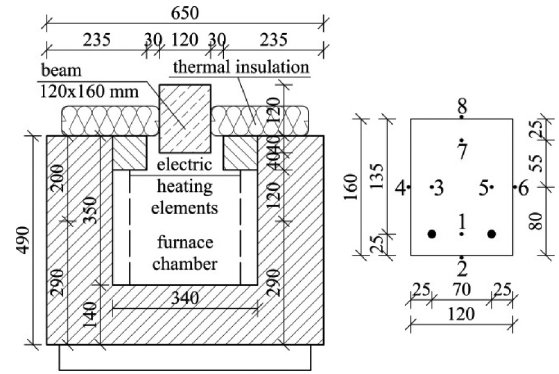
Fig. 3. Location of the beam in the furnace and thermocouples placement in the beam cross-section